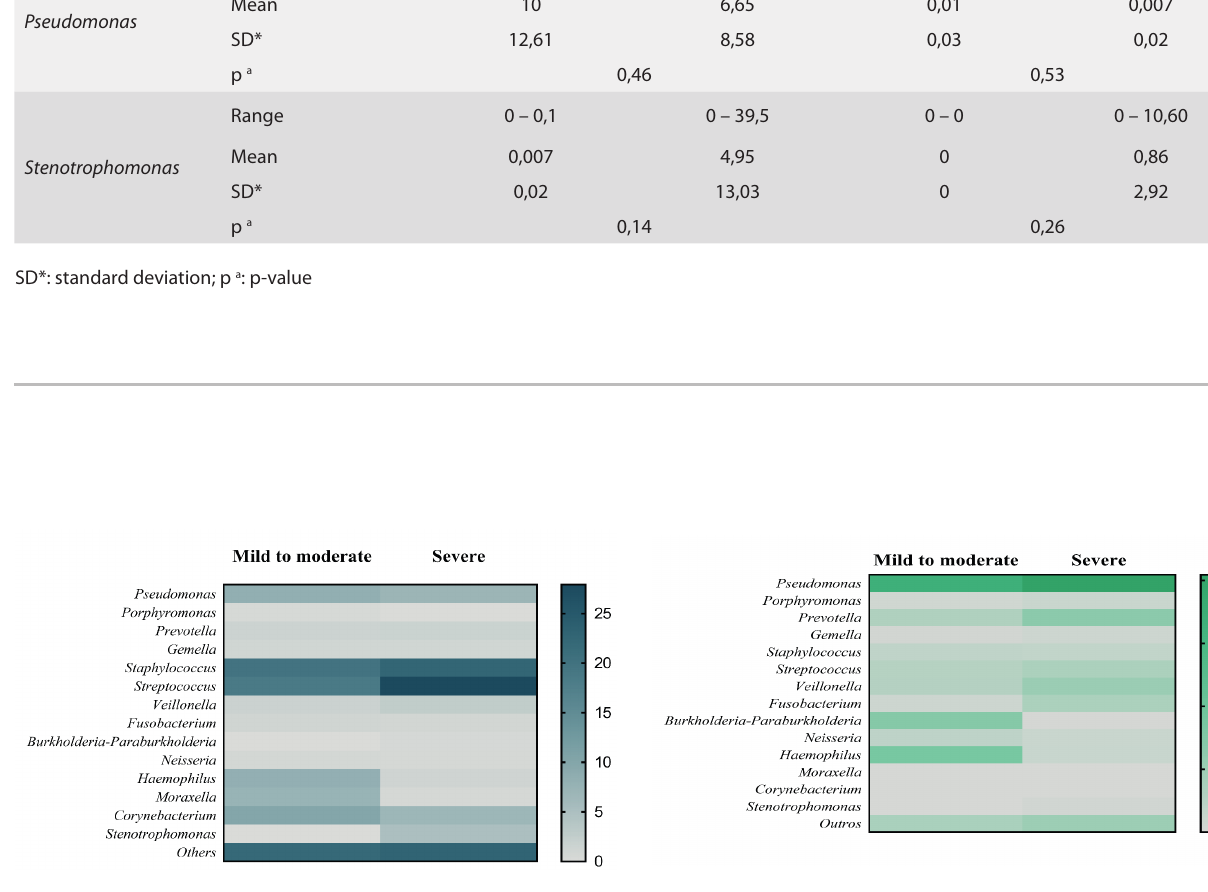
Figure S1. Heat map of bacterial genera in middle meatus accord- ing to lung disease severity. Patients with severe lung disease exhibited a greater abundance of Staphylococcus , Streptococcus and Stenotrophomonas , and a smaller abundance of Pseudomonas , Haemophilus and Corynebacterium , in comparison with those with mild to moderate lung disease.